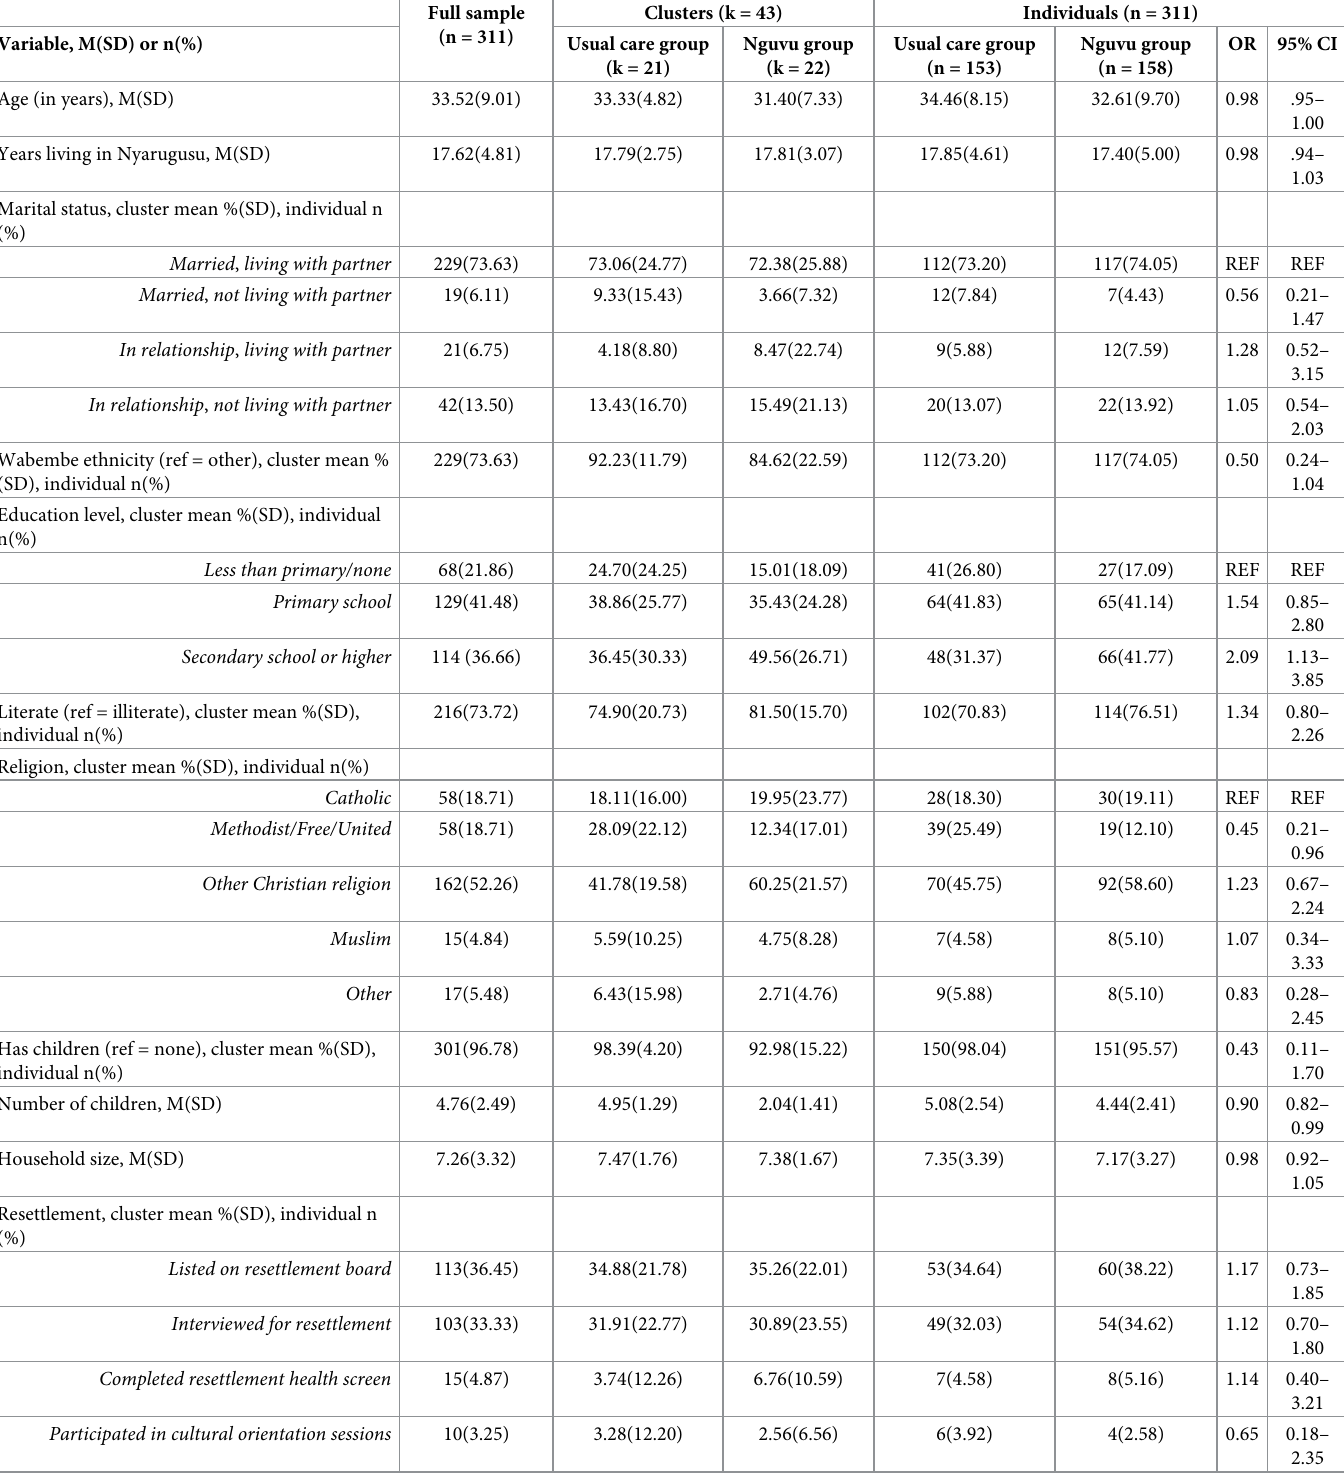
Table 1. Baseline socio-demographic characteristics of sample (k = 43 clusters, n = 311